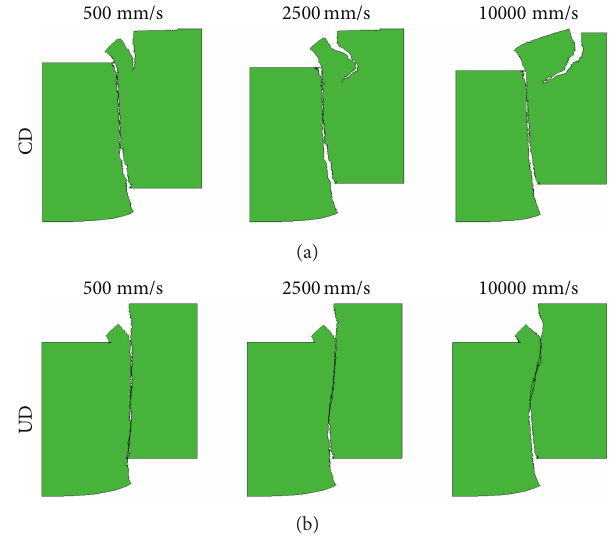
Figure 5: Variation of crack patterns in fine mesh for different displacement rates for (a) continuum damage model (CD) and (b) uncoupled damage model